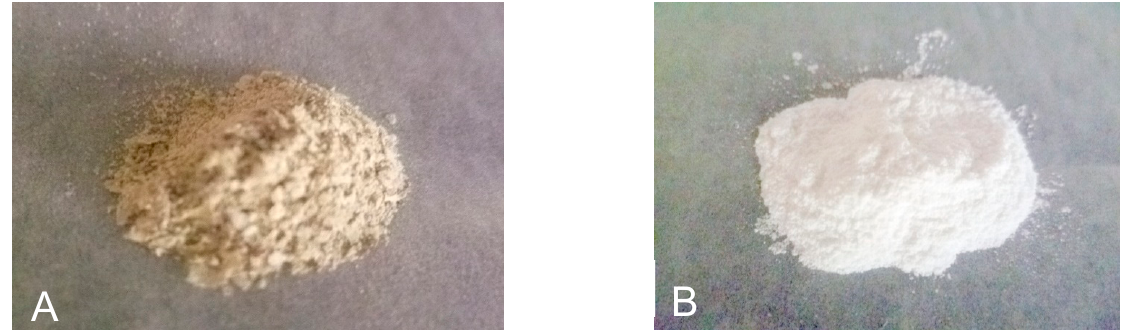
Figure 2. The total triterpenoids before purification ( A ) and after purification ( B ).